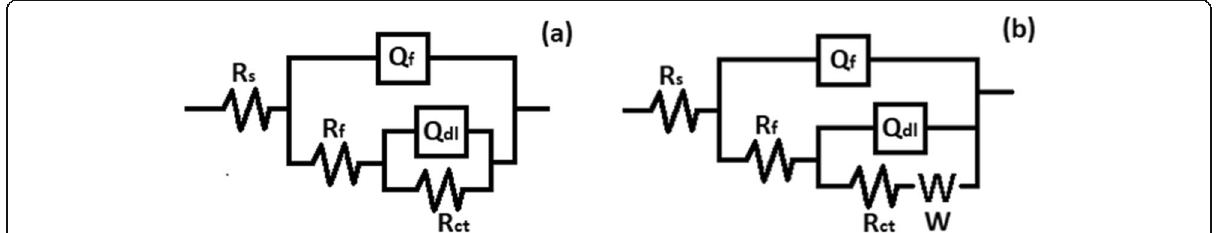
Fig. 6 Equivalent circuit models employed for assessing the EIS results